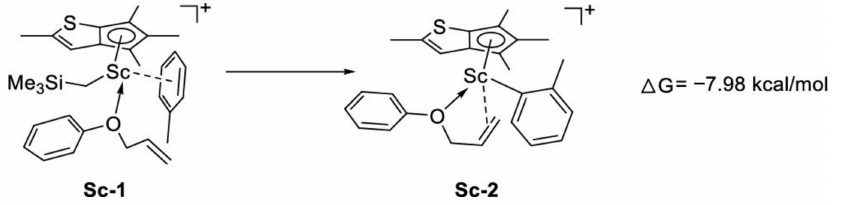
Scheme 4. Proposed mechanism for CTS in styrene polymerization triggered by allyloxybenzene. Reproduced with permission from Reference [39]. Copyright 2020 American Chemical